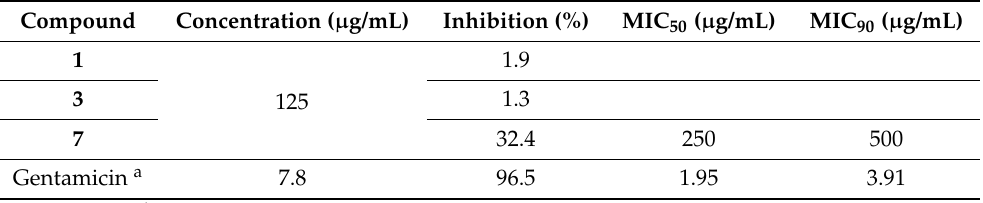
Table 1. Antibacterial activities of the selected marker compounds 1 , 3, and 7 against Staphylococcus aureus .